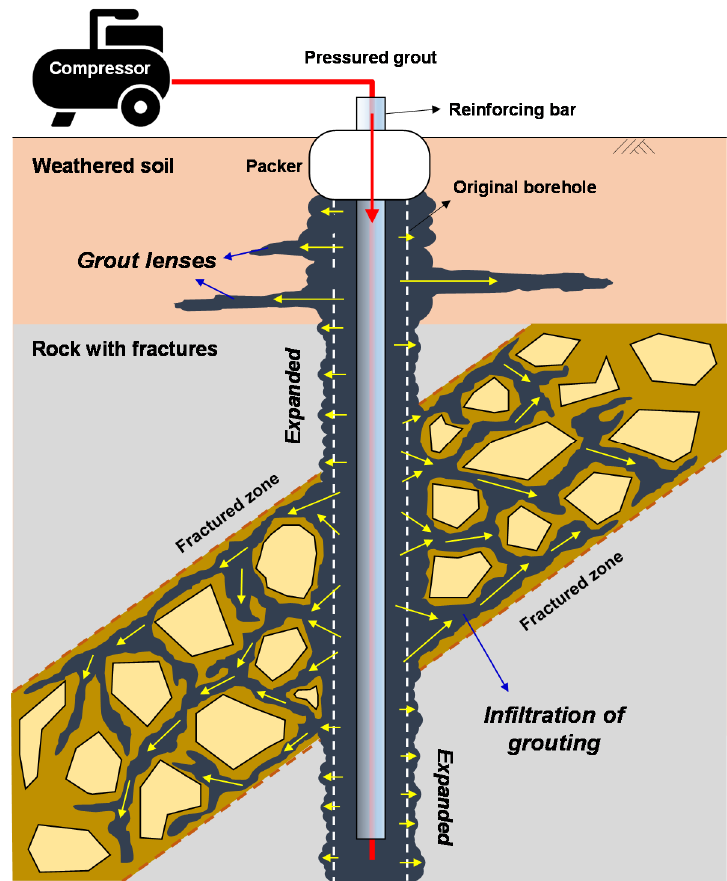
Figure 7. Micropile with pressure grouting in fractured zone.